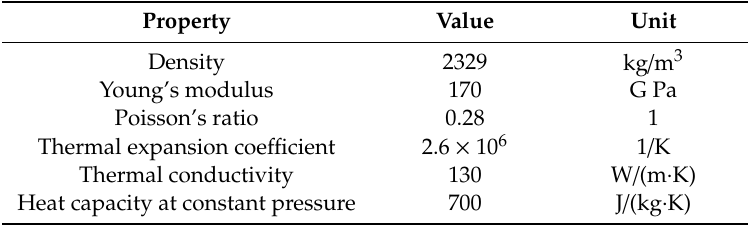
Table 1. Mechanical properties of MCL.